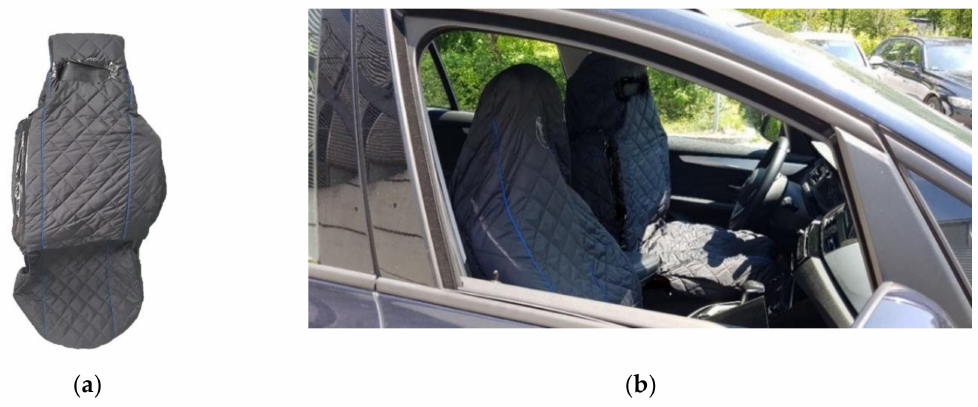
Figure 1. Wizard of Oz vehicle: ( a ) seat cover used to hide the driver; ( b ) driver hidden under the seat cover [24].